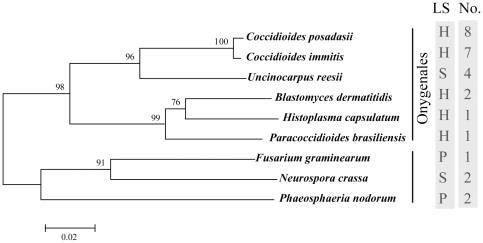
Species tree used for gene duplication and loss analyses in the study.The first column captures the life-styles of these nine fungi. H = human parasitic fungi; P = plant parasitic fungi; S = saprophytic fungi. The second column shows the gene numbers of M35 family gene in each fungus.